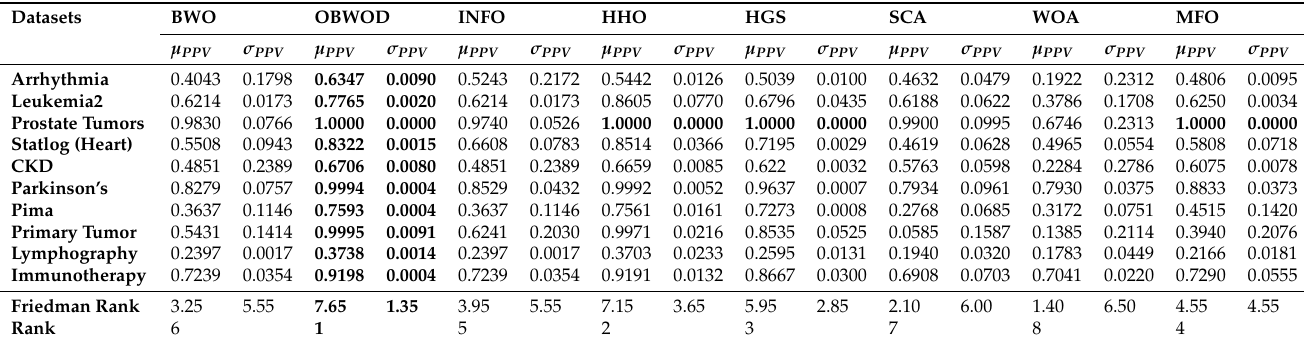
Table 12. Comparison of the precision between OBWOD and other optimization algorithms based on the kNN classifier